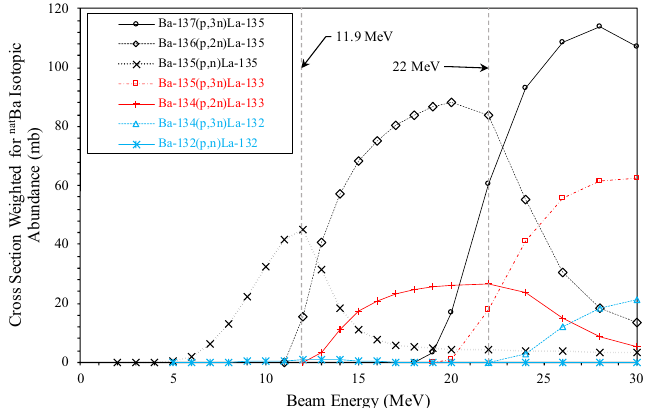
Figure 3. Nuclear reaction cross-section simulation data of the proton-induced nuclear reaction on 132/134/135/136/137 Ba for 132/133/135 La weighted for nat Ba isotopic abundance 12